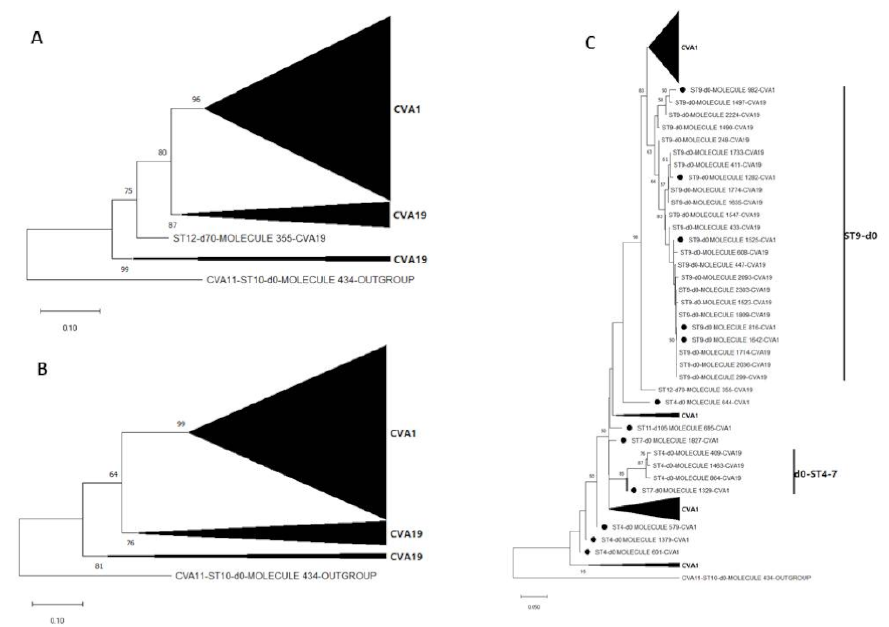
Figure 6. Maximum likelihood phylogenetic tree of CVA1 and CVA19 contigs recovered from assay 3b (LRISW) in this study ( A ) VP1-2C ( B ) VP1 only and ( C ) 2A-2C. In Figure 6C, the CVA1 contigs that do not cluster with other CVA1s are indicated with black circles. Bootstrap support is shown if >50. Abbreviation: ST = site. Collapsed taxa denote all contigs that belong to the same EV